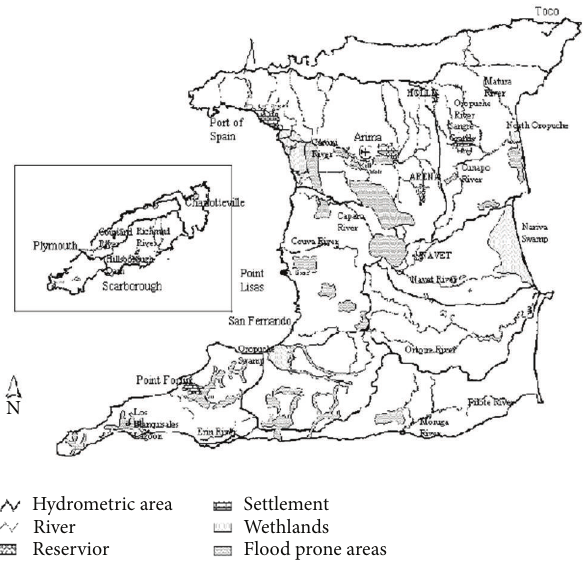
Figure 1: Water Regions (rivers, reservoirs, wetlands and hydro- metric areas) in Trinidad and Tobago where solar photochemical reactors can be applicable [ courtesy Key North Engineering Ltd